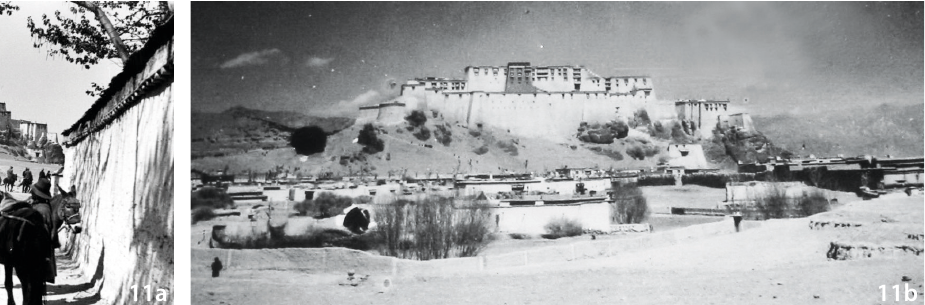
Figure 11a Photo of Sangzhutse Fortress and the village taken by Ernst Schäfer in 1930s (Source: https://commons.wikimedia.org/wiki/ File:Bundesarchiv_Bild_135-S-17-26-30,_Tibetexpedition,_Blick_auf_ Burg.jpg) Figure 11b Photo taken by Chen Zonglie during 1950s (Source: Chen Zonglie). Figure 12a Paramona of the Sangzhutse Fortress after destruction (Source: Shigatse Region Administration) Figure 12b Ruins of the Sangzhutse Fortress wall (Source: the